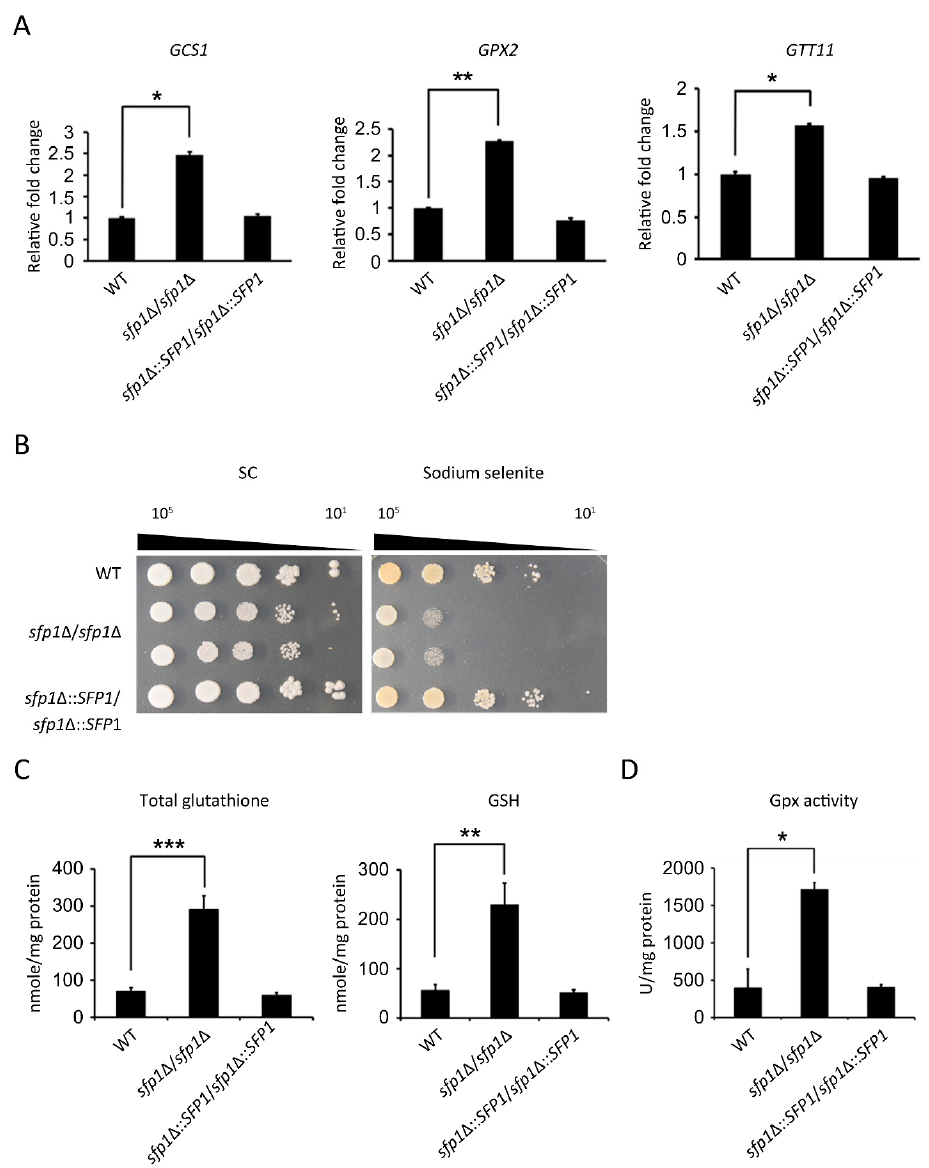
Figure 6. Sfp1 regulates the glutathione system in response to H 2 O 2 . ( A ) GCS1, GPX2, and GTT11 gene expression levels were detected using real-time qPCR. The PMA1 transcript was used as an endogenous control. The results are presented as the mean ± standard deviation (SD) of three independent experiments. ** P < 0.01. * P < 0.05. ( B ) One colony was inoculated into YPD medium and grown at 30 ◦ C overnight. This culture was harvested by centrifugation and washed with sterile double-distilled water (ddH 2 O). Cells were ten-fold serially diluted and spotted onto YPD agar with or without 3 mM sodium selenite. The agar plates were incubated at 30 ◦ C for 3–4 days. Representative images of three independent experiments with identical results are shown. ( C ) Cells were treated with 1 mM H 2 O 2 for 2 h. The GSH and GSSG content was determined by measuring TNB absorbance at 415 nm. The GSH content was determined as follows: [total glutathione]–2[GSSG]. The results are presented as the mean ± standard deviation (SD) of three independent experiments. ** P < 0.01. *** P < 0.001. ( D ) Cells were treated with 1 mM H 2 O 2 for 2 h. The enzyme activity of glutathione peroxidase (Gpx) was determined by the oxidation of NADPH. The results are presented as the mean ± standard deviation (SD) of two independent experiments. * P <